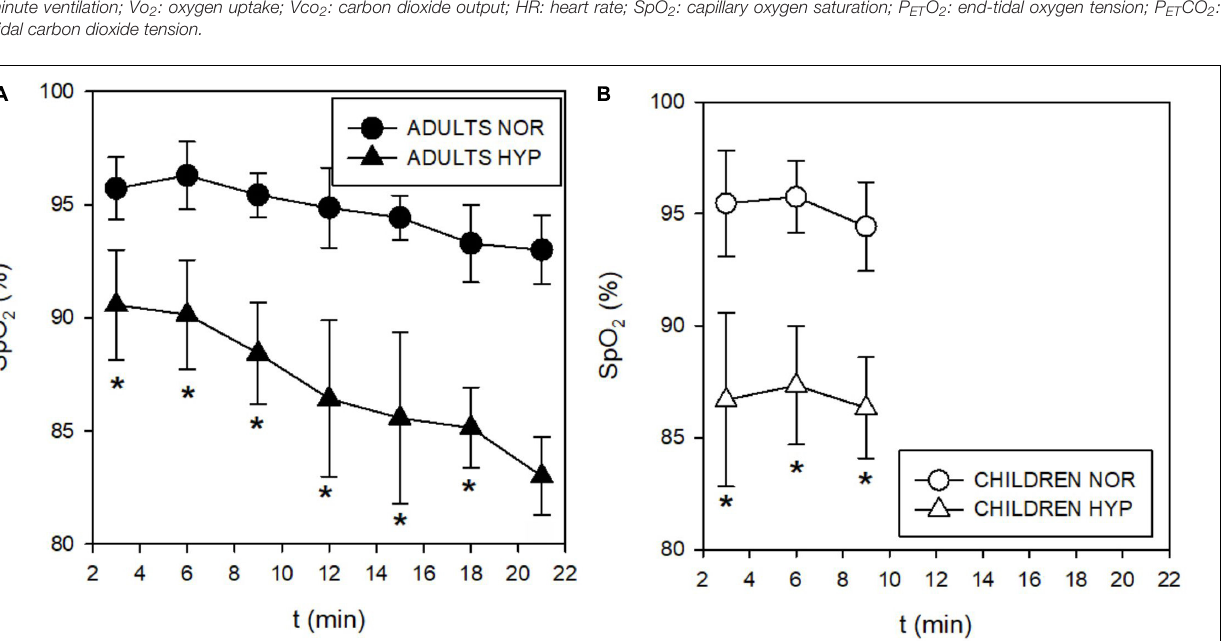
tendency for an increase in children ( Table 1 ). Absolute as well